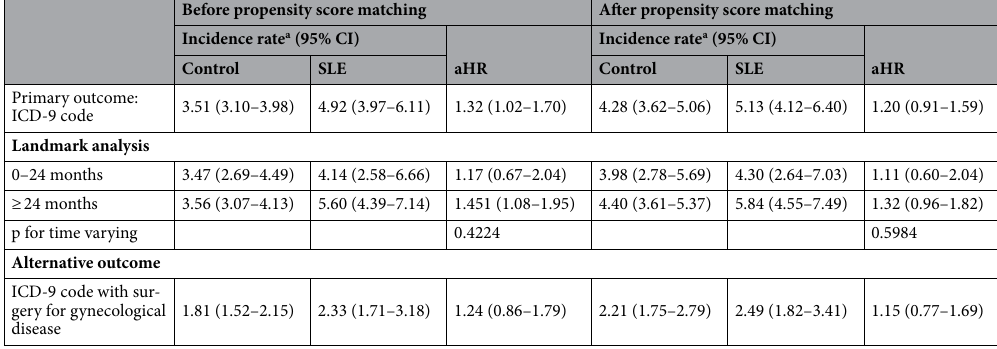
Table 4. Sensitivity analysis of endometriosis risk in SLE and non-SLE patients. aHR adjusted hazard ratio, controlling age, urbanization, hospital stay, and comorbidity at baseline. a Incidence rate, per 10,000 person-